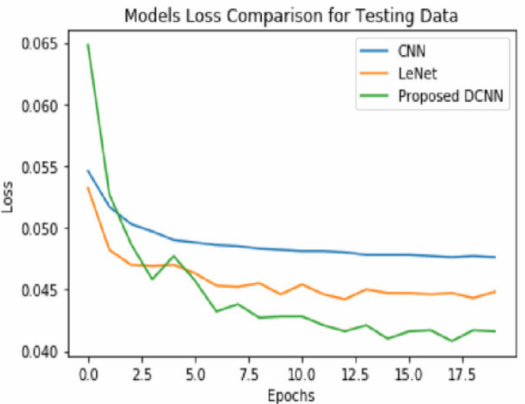
Figure 16. Loss Comparison of CNN, LeNet, and the Proposed DCNN on the Combined Pashto Digit and Character Dataset.